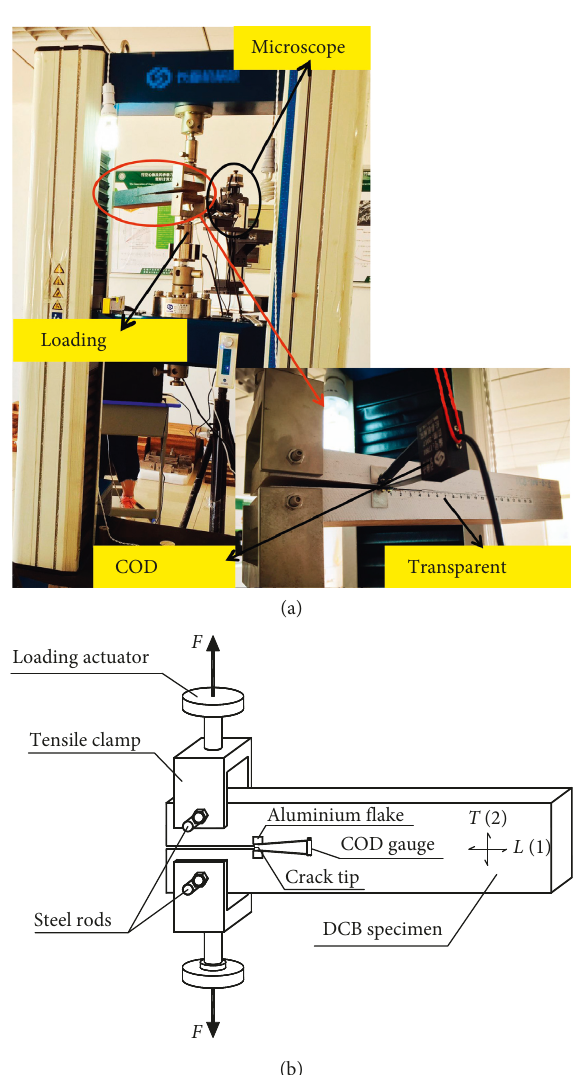
Figure 4: (a) Experimental setup of the DCB test. (b) Schematic diagram of the DCB